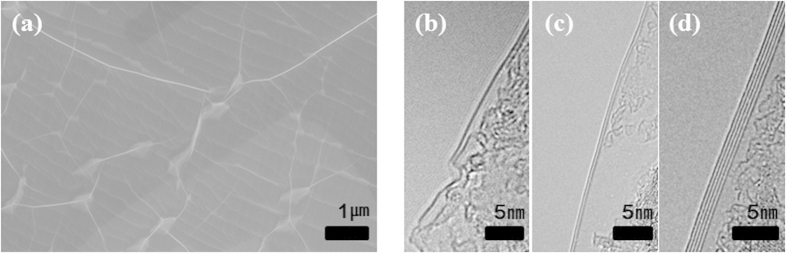
SEM image of full-covered h-BN on the Ni foil with ECP/APH2-30 min;(b–d) TEM image of h-BN.